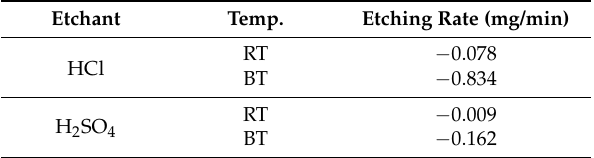
Figure 3. Relation between surface roughness and sandblasting time, angle.